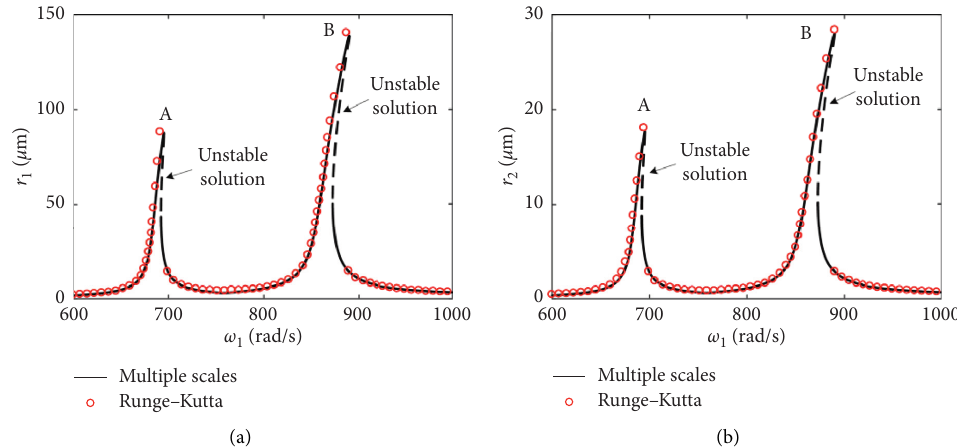
Figure 3: Amplitude frequency curves solved by the multiple scales method and the Runge–Kutta method. (a) For the LP rotor. (b) For the HP rotor. Solid lines represent stable solutions, and dotted lines represent unstable